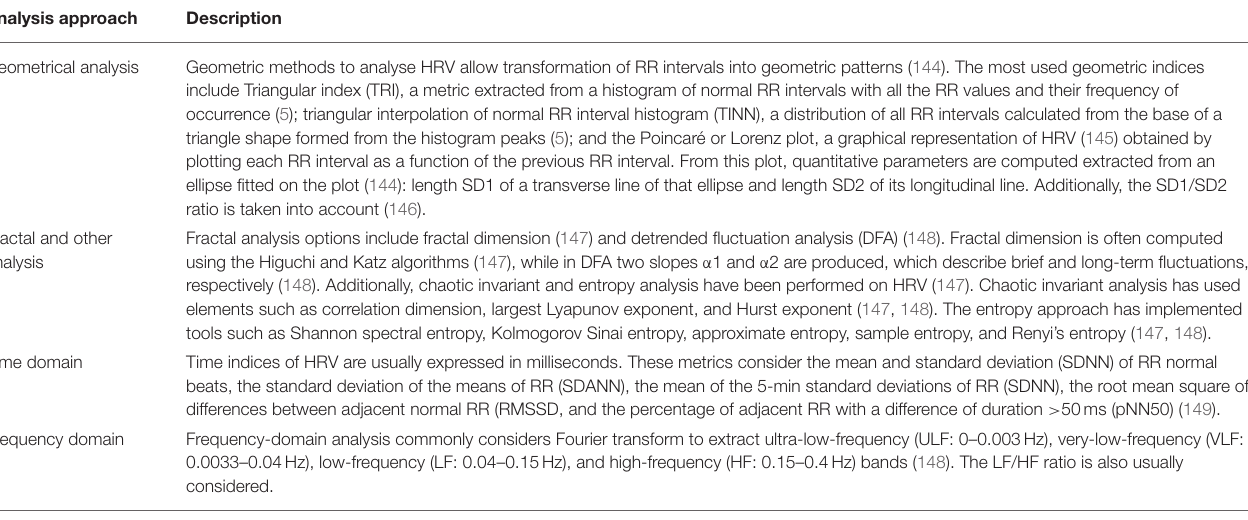
TABLE 3 | Analysis of HRV